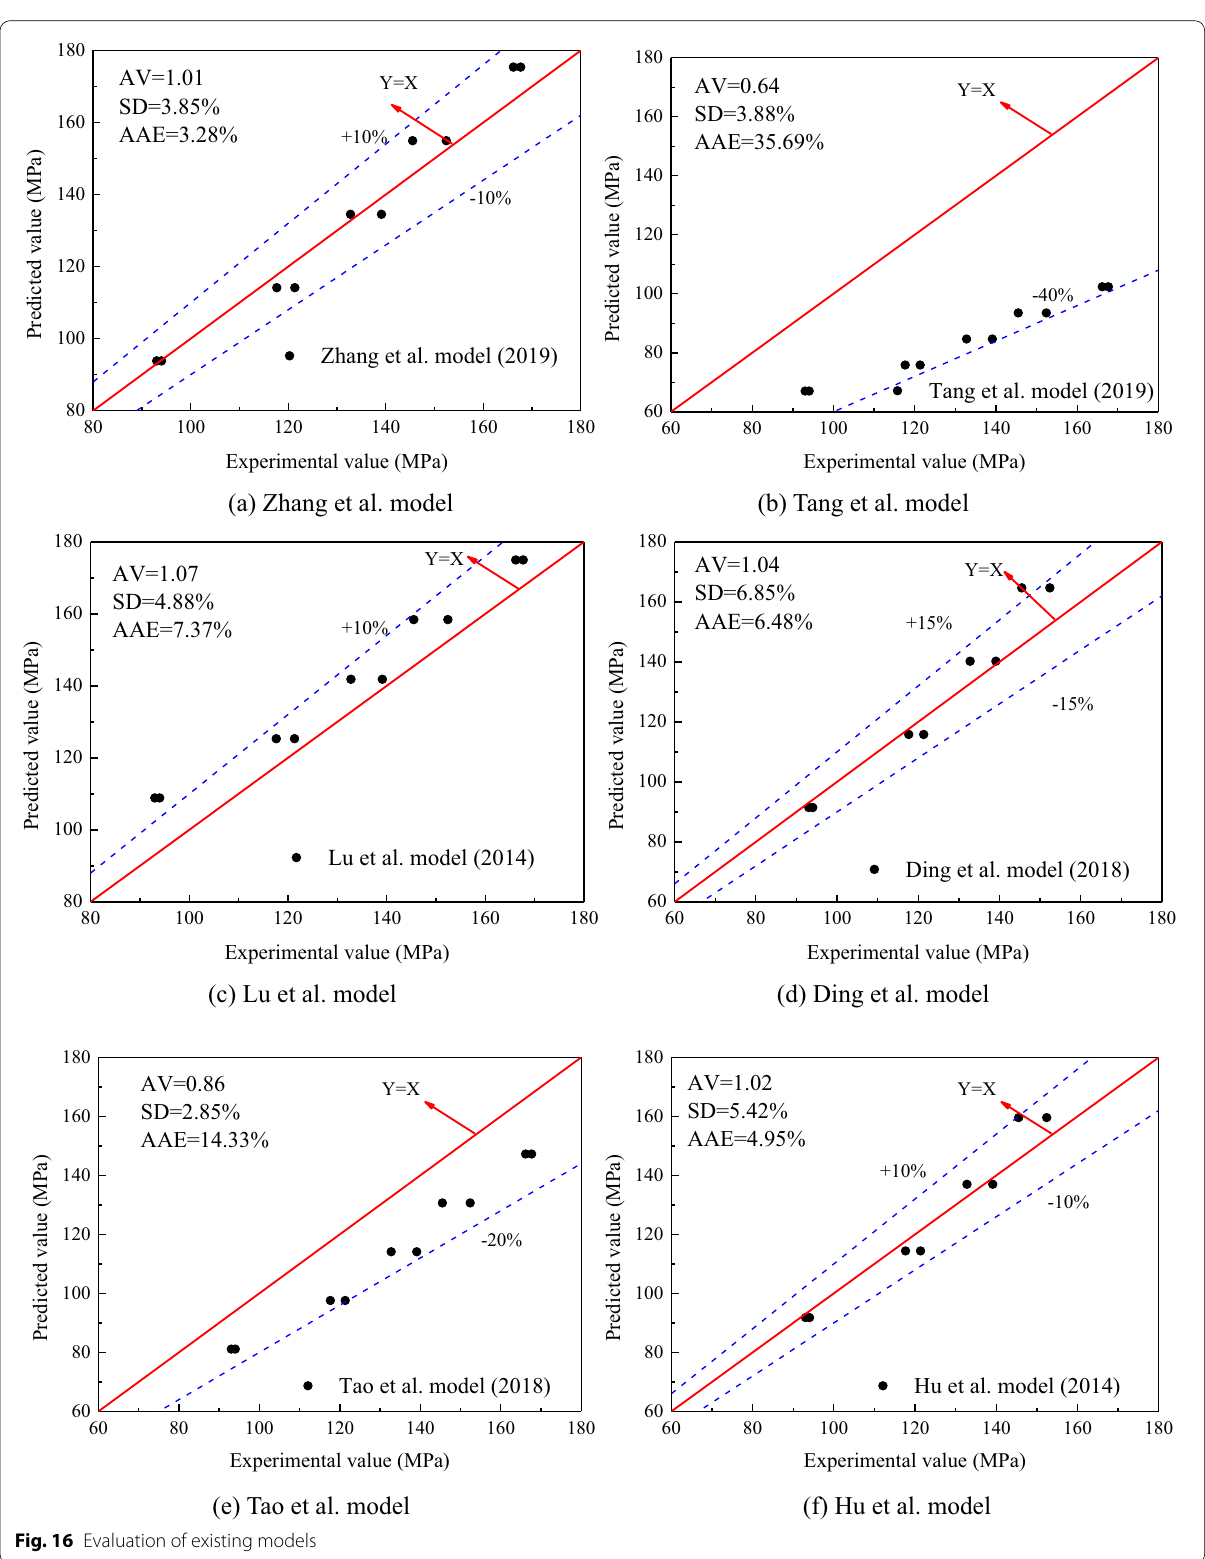
Fig. 16 Evaluation of existing